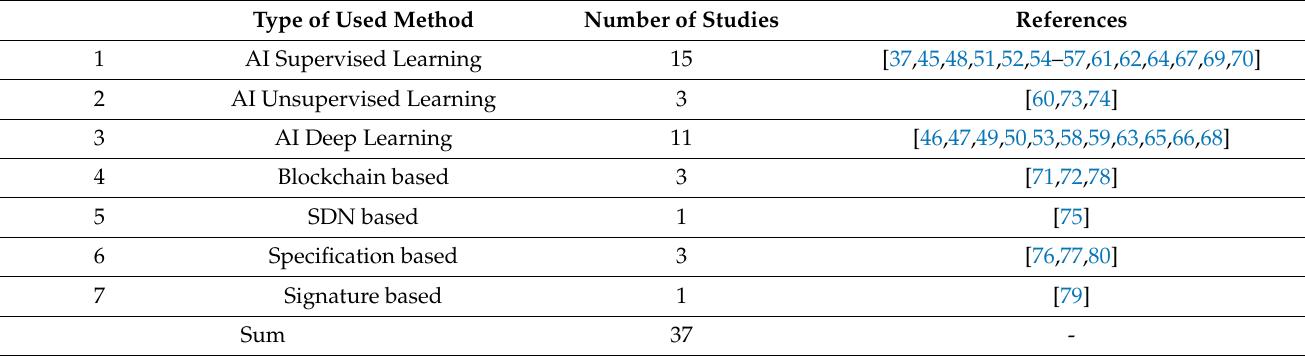
Figure 10. Number of publications per year. Table 11. Number of studies selected per detection method.